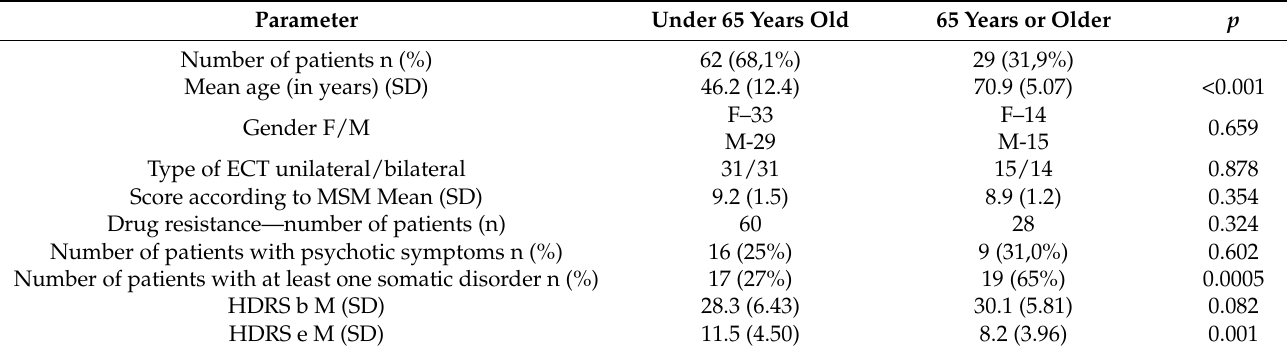
Table 1. Clinical and demographic characteristics of participants.